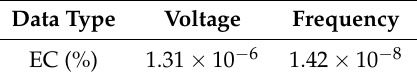
Table 1. Energy contribution of PMU data